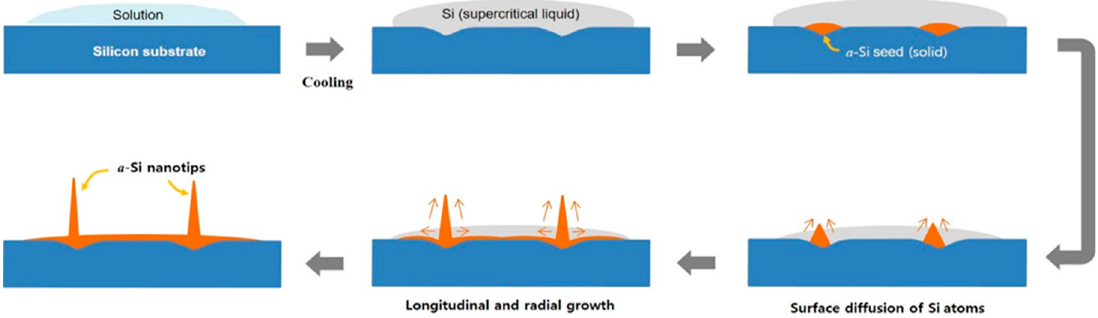
Figure 4. Schematic illustration of a -Si nanotip growth.